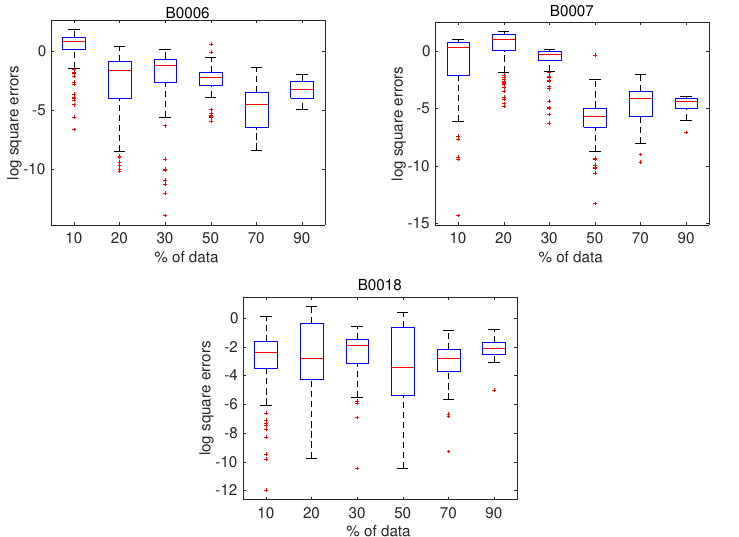
Figure 2. Boxplots of the square errors in the prediction of the time interval δ t ( n ) for the B0006, B0007, and B0018 data